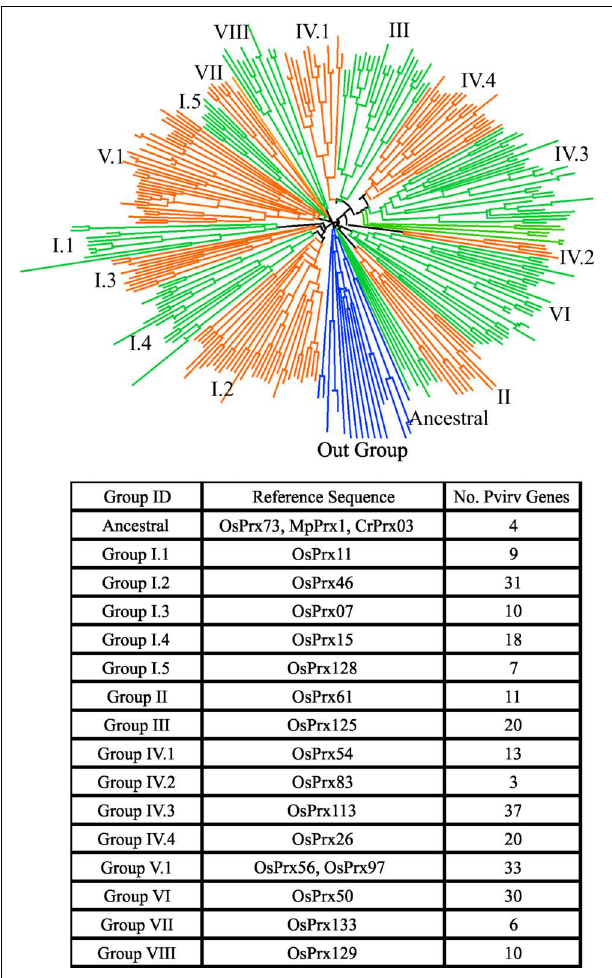
FIGURE 2 | Phylogenetic relationships and numbers within each evolutionary clade, as defined for rice, for switchgrass class III peroxidases. The distribution of peroxidases relative to the out-group sequences (blue lines) are shown in the circular phylogram.The rice and ancient peroxidase protein sequences used as representatives for these analyses, and the numbers of switchgrass members in each clade are indicated.The peroxidase sequences include loci from both the A and B